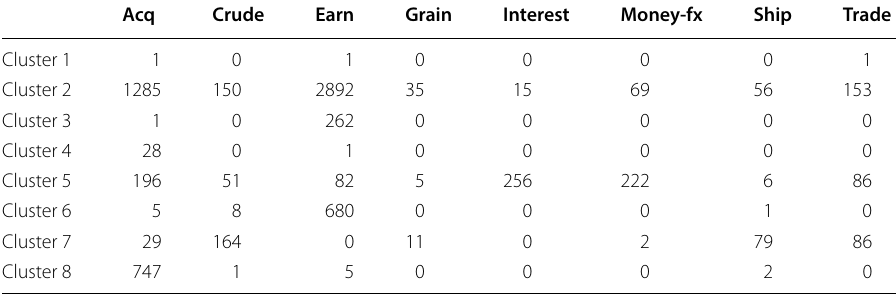
Table 13 The category distribution in clusters generated by PDSM (R8, tf-idf)